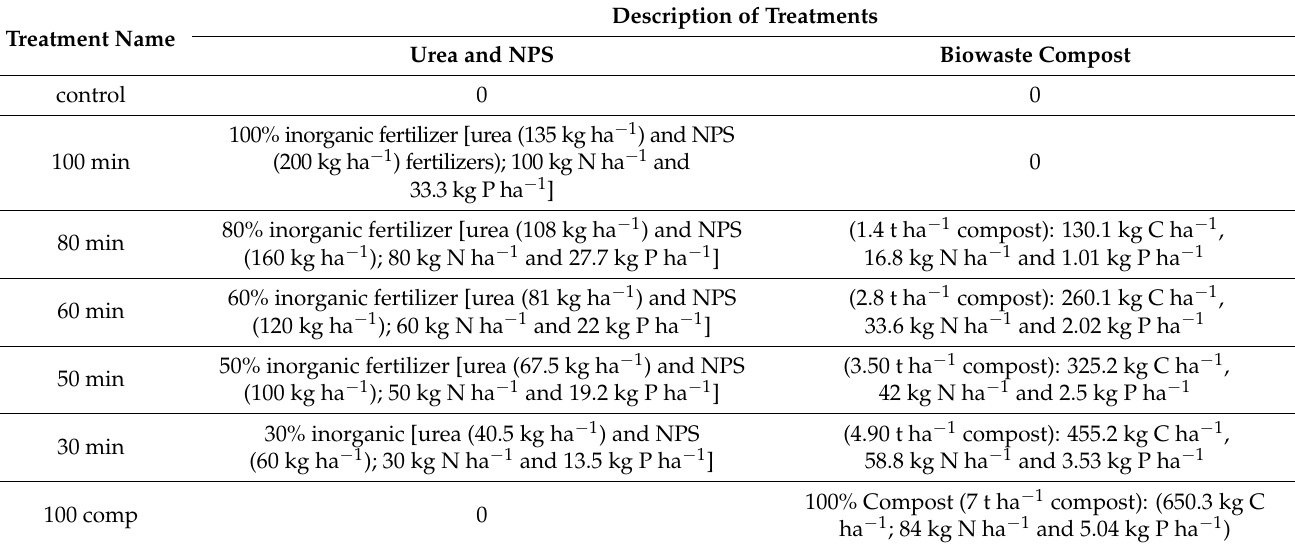
Table 2. Description and nutrient application of the treatments applied in the